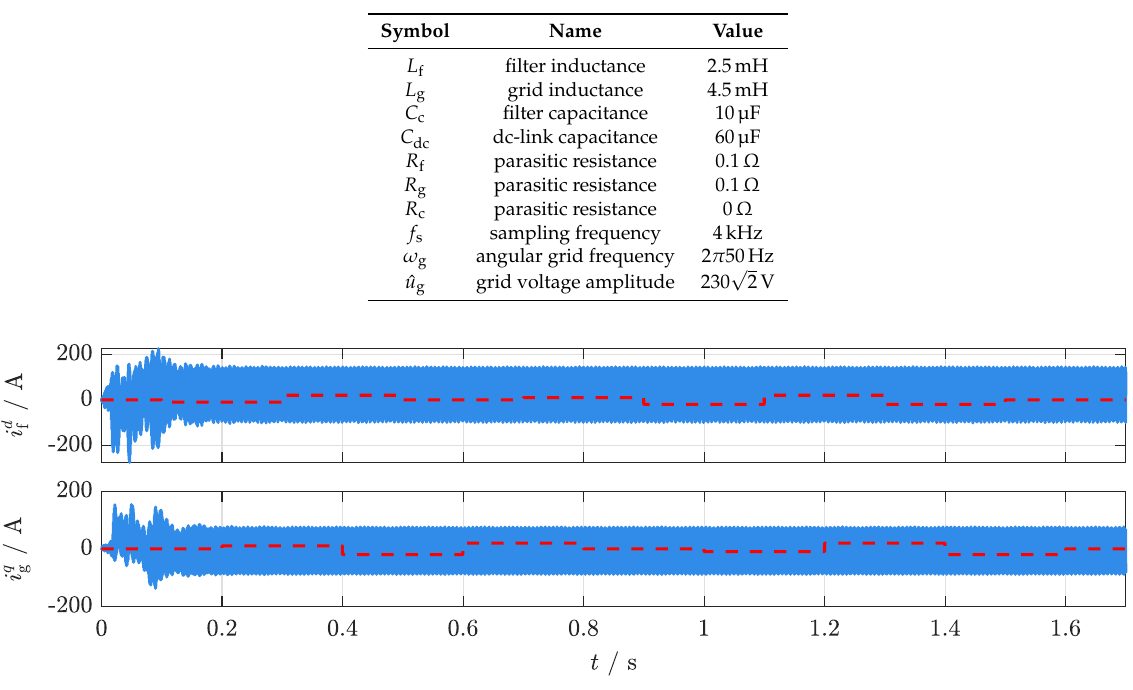
, i q , i d g and i q g , f f